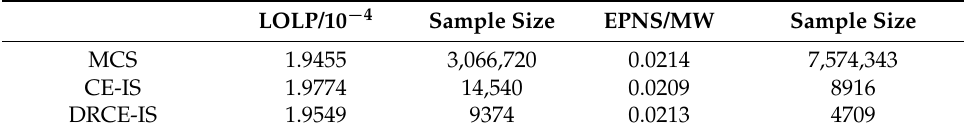
Table 5. Reliability indices of the modified IEEE-RTS 79 system with four dependent wind